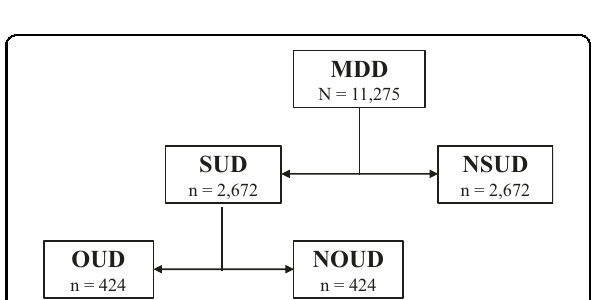
Fig. 2 Classi fi cation of the MDD-OUD, MDD-NOUD, and MDD- NSUD comparison groups. Nearest neighbor matching was the technique we used for propensity score matching, and this analysis was performed using the MatchIt package in R version 3.6.0. The covariates (age, gender, and comorbidity) were matched using the propensity score distance measure and a one-to-one (1:1 ratio) matching approach was used to select the best control subject for each case subject. The speci fi c comorbidities applied in the propensity scoring algorithm are listed in Table 1 under “ Clinical Status, ” however note that the overall and subcategories of “ Co-Occurring Mental Health Disorder(s) ” and “ Substance Use Disorder (SUD) ” were not applied as these variables serve to distinguish the comparison groups. The time frame used for propensity score matching was 1 January 2008 to 31 December 2017 (the full time period of observation for this study). Detailed results in terms of the propensity score matching analysis are included in the